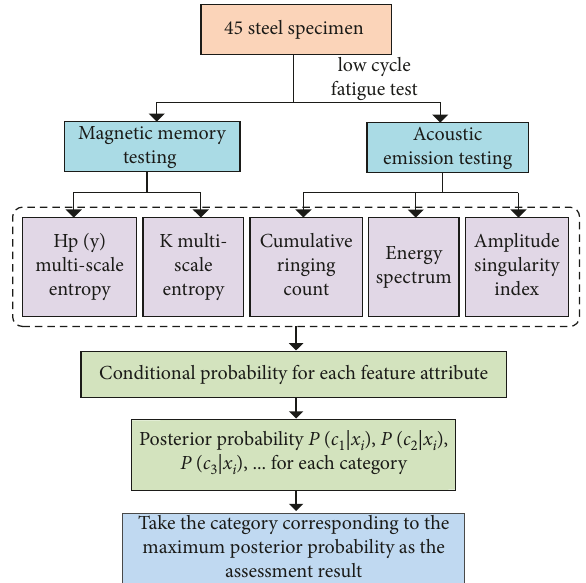
Figure 2: Magnetic-acoustic feature fusion and damage assessment process based on Naive